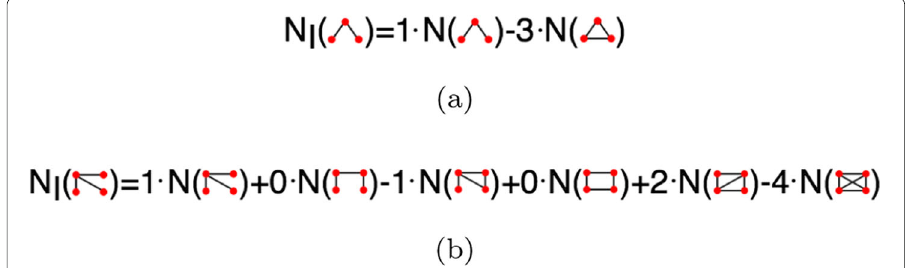
The same coefficients can be used to estimate the variance of the induced count of m , V [ N I ( m ) ]. However, the calculation of variance requires not only the variances of all k -nodes subgraphs but also all covariances between them. More formally: